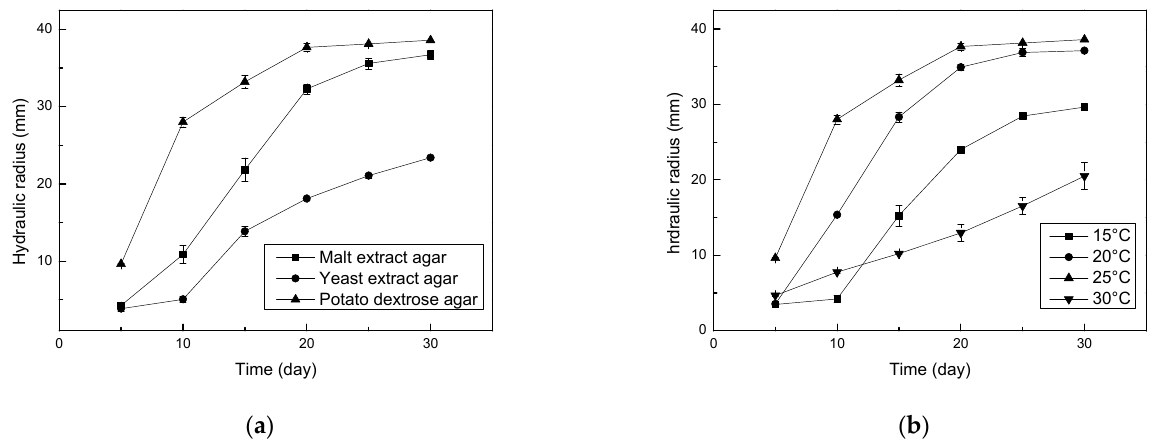
Figure 2. Effect of ( a ) cultivated media and ( b ) temperature on the hydraulic radius of HE mycelia.